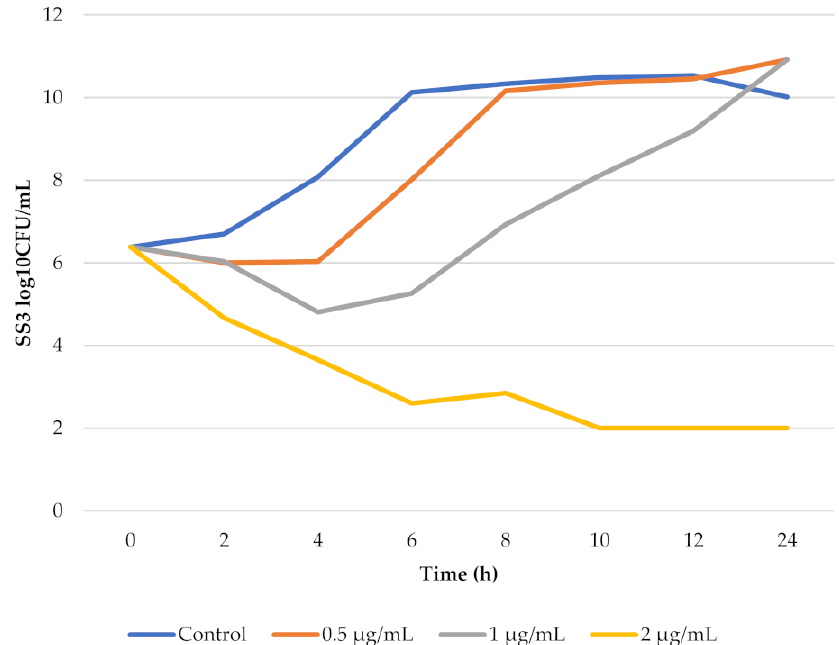
Figure 3. The bacterial growth-time curve and the in vitro killing-time curve of florfenicol against SS3 in BHI liquid broth. In the control, no florfenicol was added, and 0.5 µ g/mL, 1 µ g/mL and 2 µ g/mL were equal 1/2 MIC, 1 MIC and 2 MIC values,